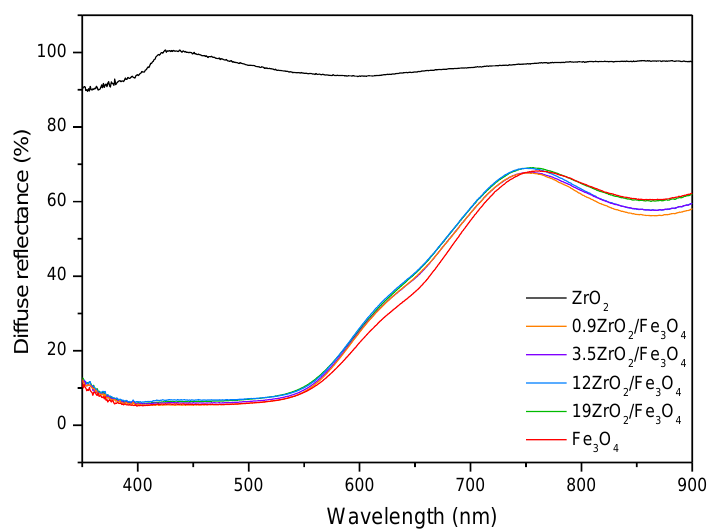
Figure 3. UV-vis DRS of particles Fe 3 O 4 and ZrO 2 , as well as synthesized ZrO 2 /Fe 3 O 4 nanоpow- ders.